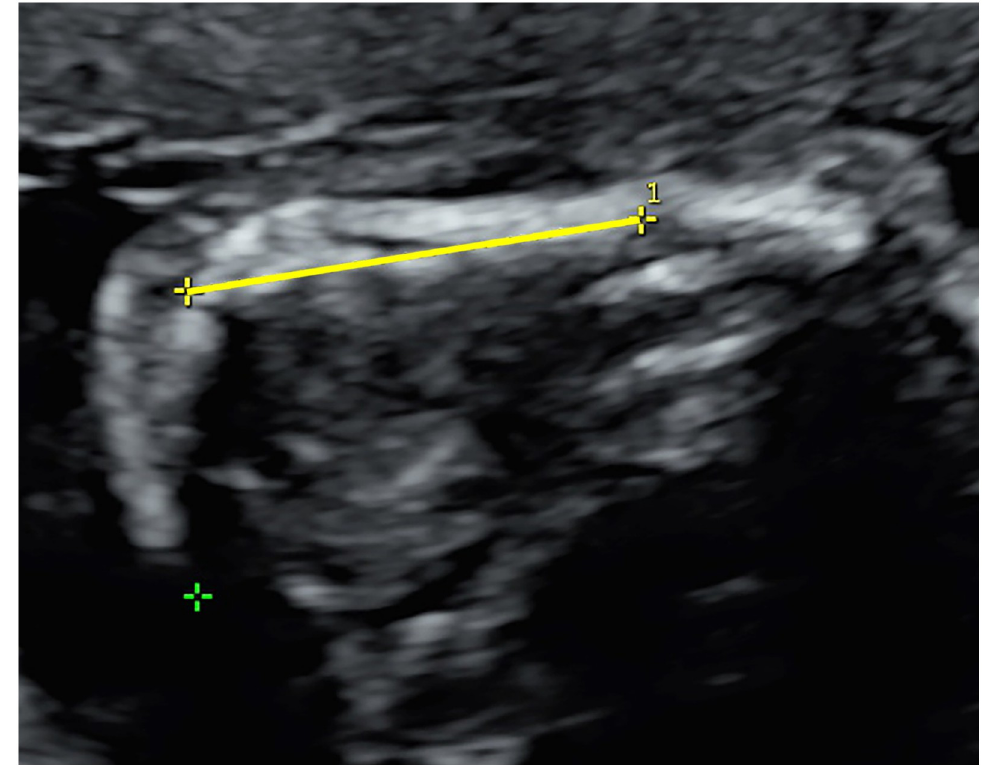
Fig 4. Mandible length (ML)